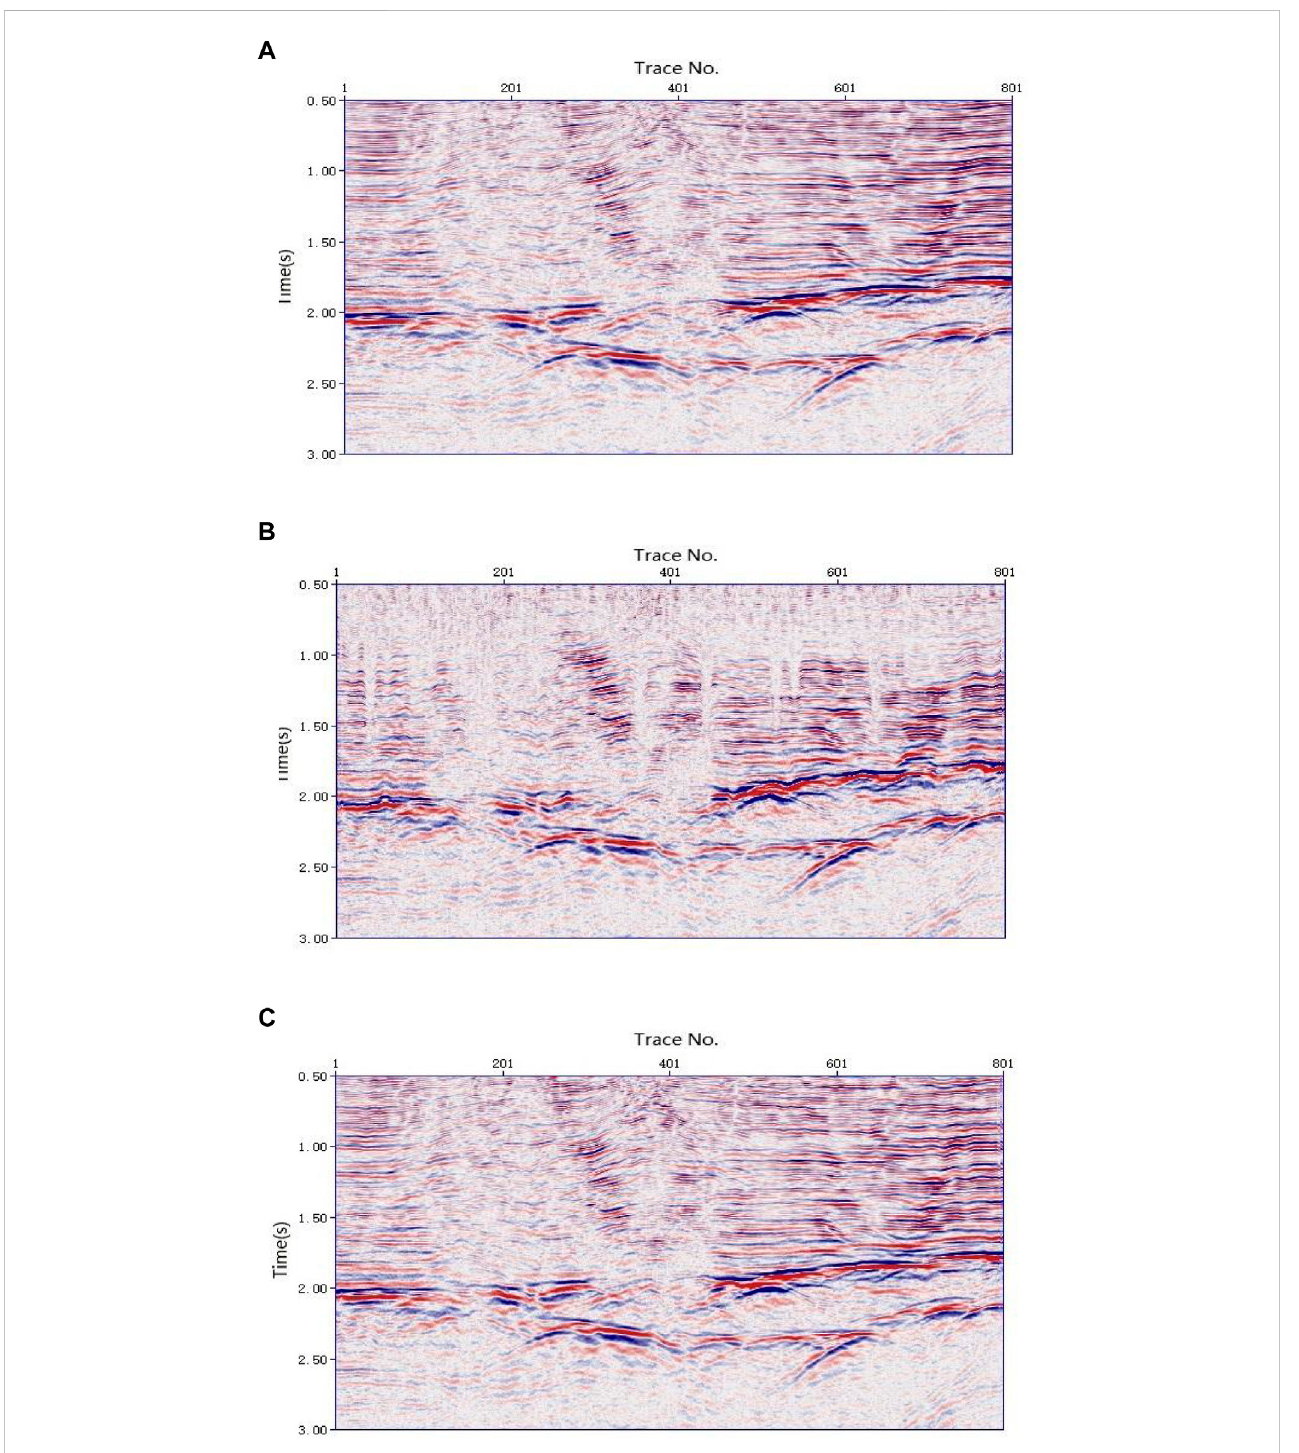
FIGURE 11 Stacked pro fi les obtained by applying three kinds of velocity fi elds. (A) Stacked pro fi le obtained by applying the manually picked velocities. (B) Stacked pro fi le obtained by applying the velocities picked by the conventional k-means clustering method. (C) Stacked pro fi le obtained by applying the velocities picked by the weighted k-means clustering